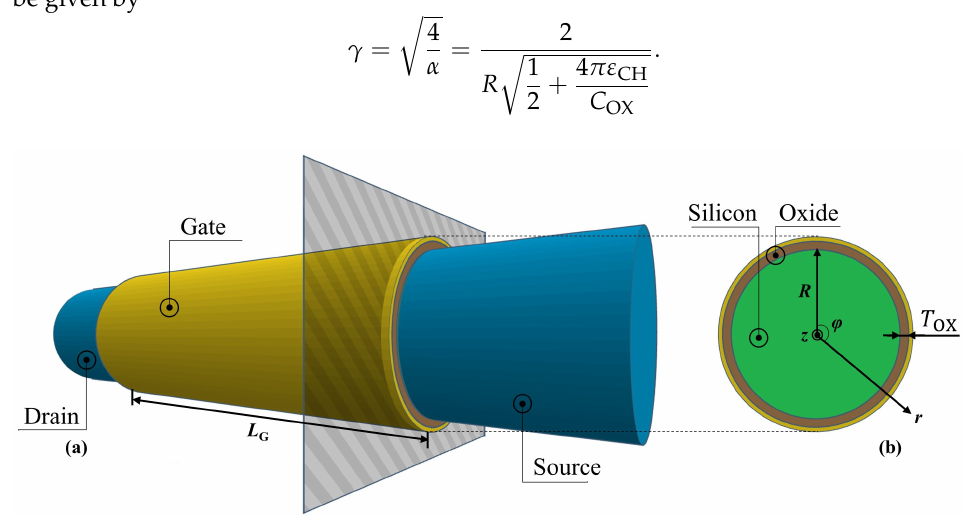
Figure 1. Schematic structure ( a ) in the channel direction z and ( b ) in the transverse direction r of the nanowire GAA MOSFET